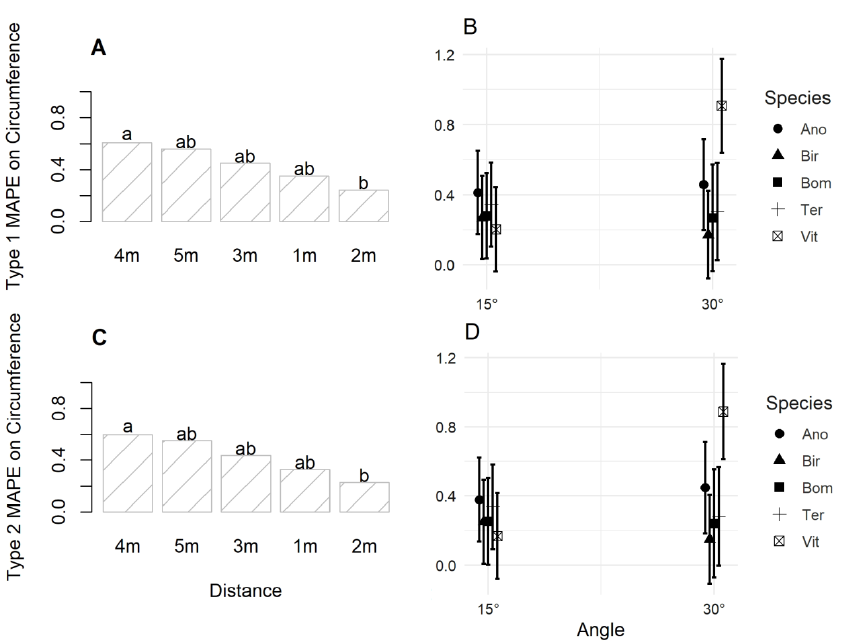
Figure 7. MAPE of breast height circumference in relation to distance ( A , C ) and species ( B , D ). Ano: Anogeissus leiocarpa ; Bom: Bombax costatum ; Bir: Sclerocarya birrea ; Ter: Terminalia laxiflora ; Vit: Vitellaria paradoxa. Histogram bars with different letters (a and b) differ significantly (Waller-Duncan test, p < 0.05).